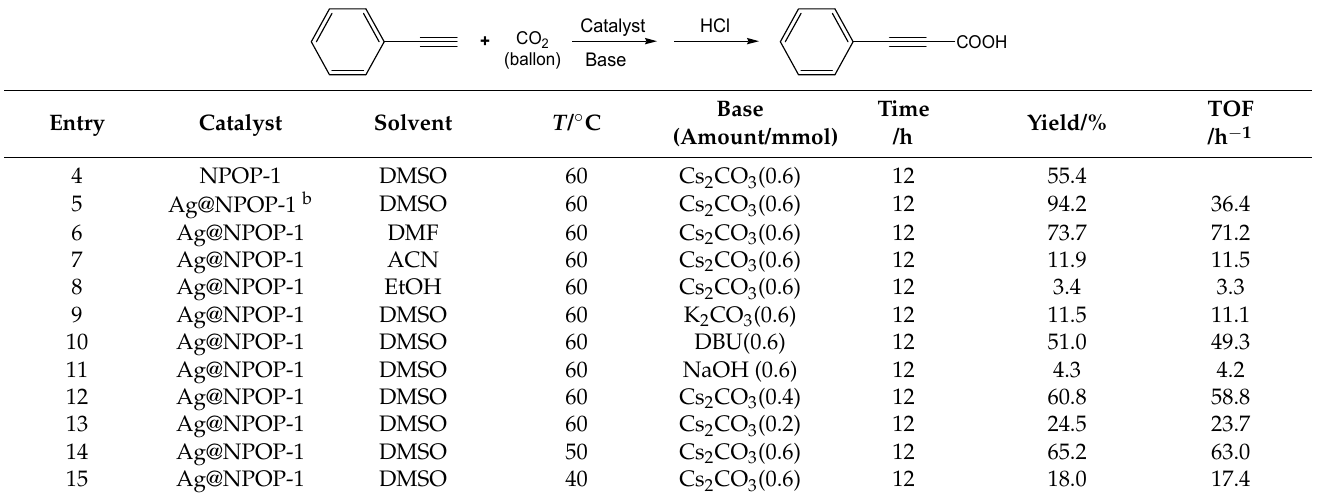
Table 2. Catalysis of NPOPs and Ag@NPOPs for the carboxylation of phenylacetylene with CO 2 a .